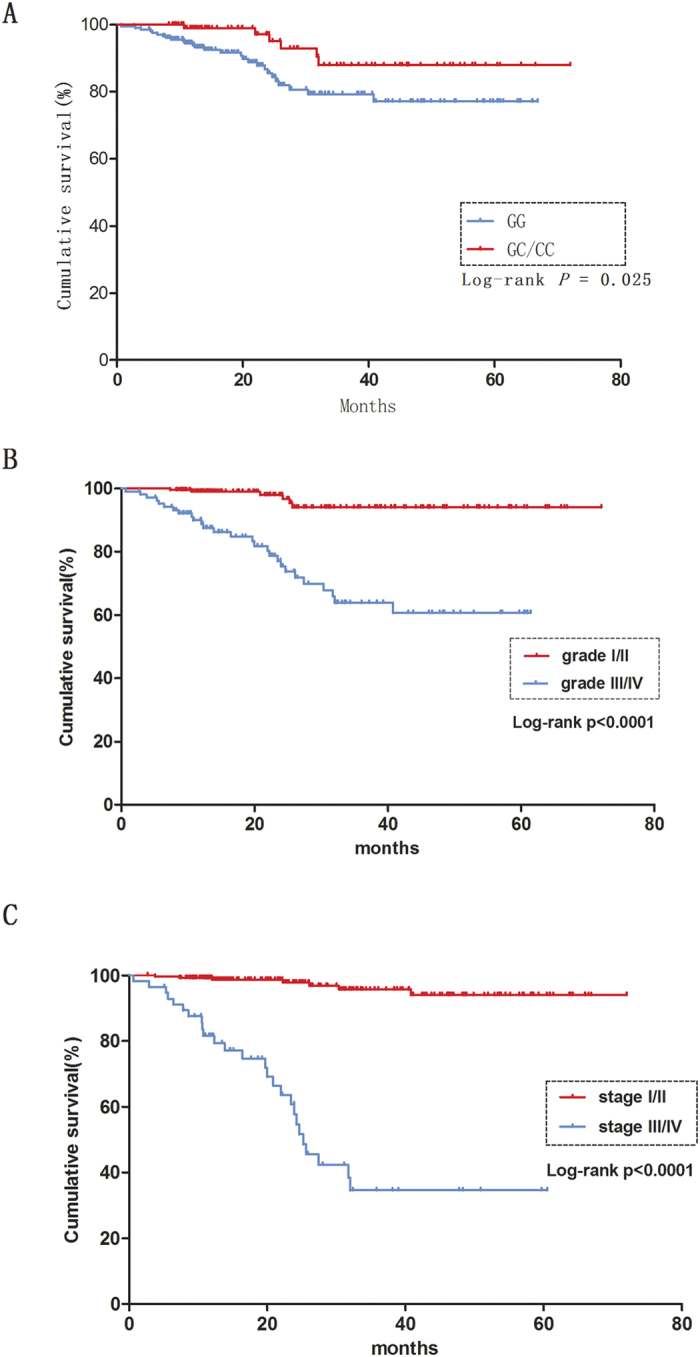
Kaplan-Meier survival curves showing RCC overall survival according to: (A) IGF1 rs5742714 (GC/CC vs. GG), (B) tumor grade (I + II and III + IV), and (C) clinic stage (I + II and III + IV).